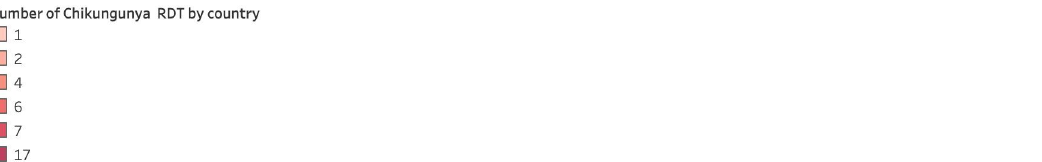
Fig 1. Number of CHIKV RDTs developed or commercialized for POC application by country of manufacture. AU : AbbreviationlistshavebeencompiledforthoseusedinFigs 1 ; 4 ; and 5 : Pleaseverifythatallentriesarecorrect : The world map was created, edited, and colored using Microsoft Excel for Mac, version 16.61.1. Public domain link to map base layer used in creating the figure is available: https://commons.wikimedia.org/wiki/File:BlankMap-World.svg. CHIKV, Chikungunya; POC, point-of-care; RDT, rapid diagnostic test.